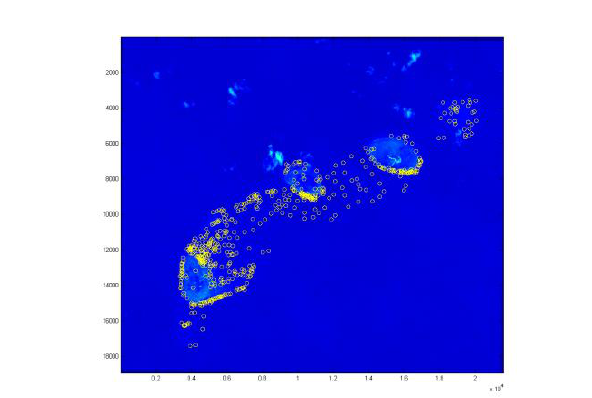
Figure 5. The sub-image scene from